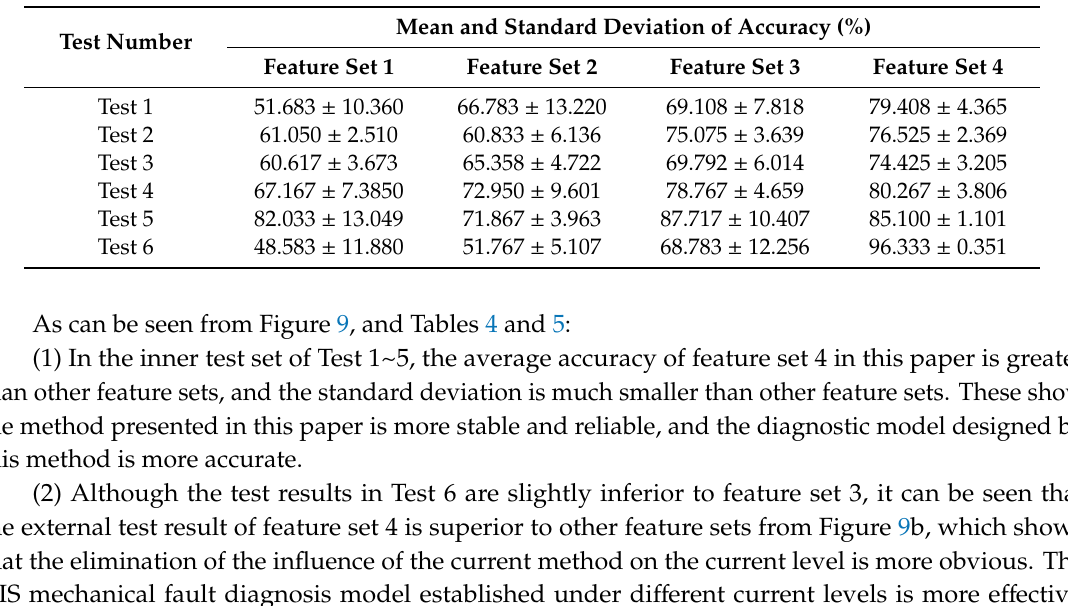
Table 5. Accuracy (mean and standard deviation, %) of external testing under di ff erent test